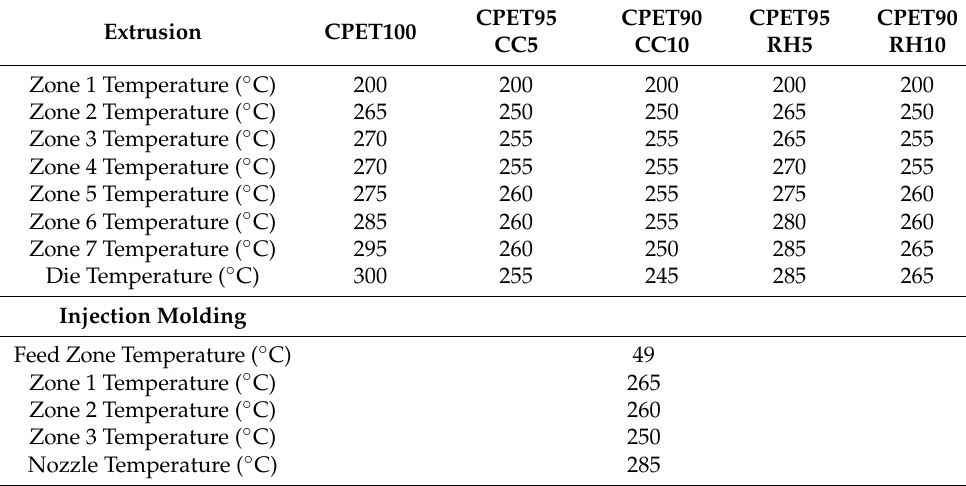
Table 2. Processing parameters of CPET/biofiller